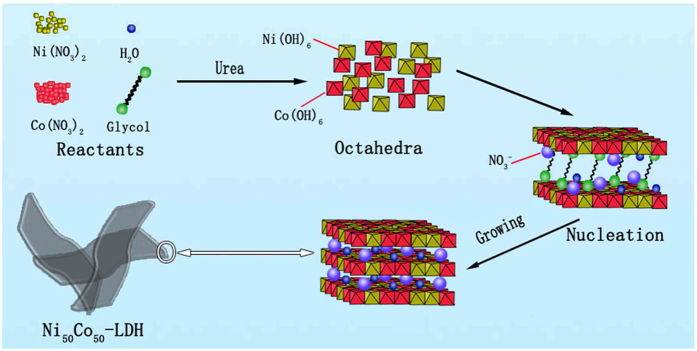
Schematic illustration of growth mechanism of Ni50Co50-LDH.